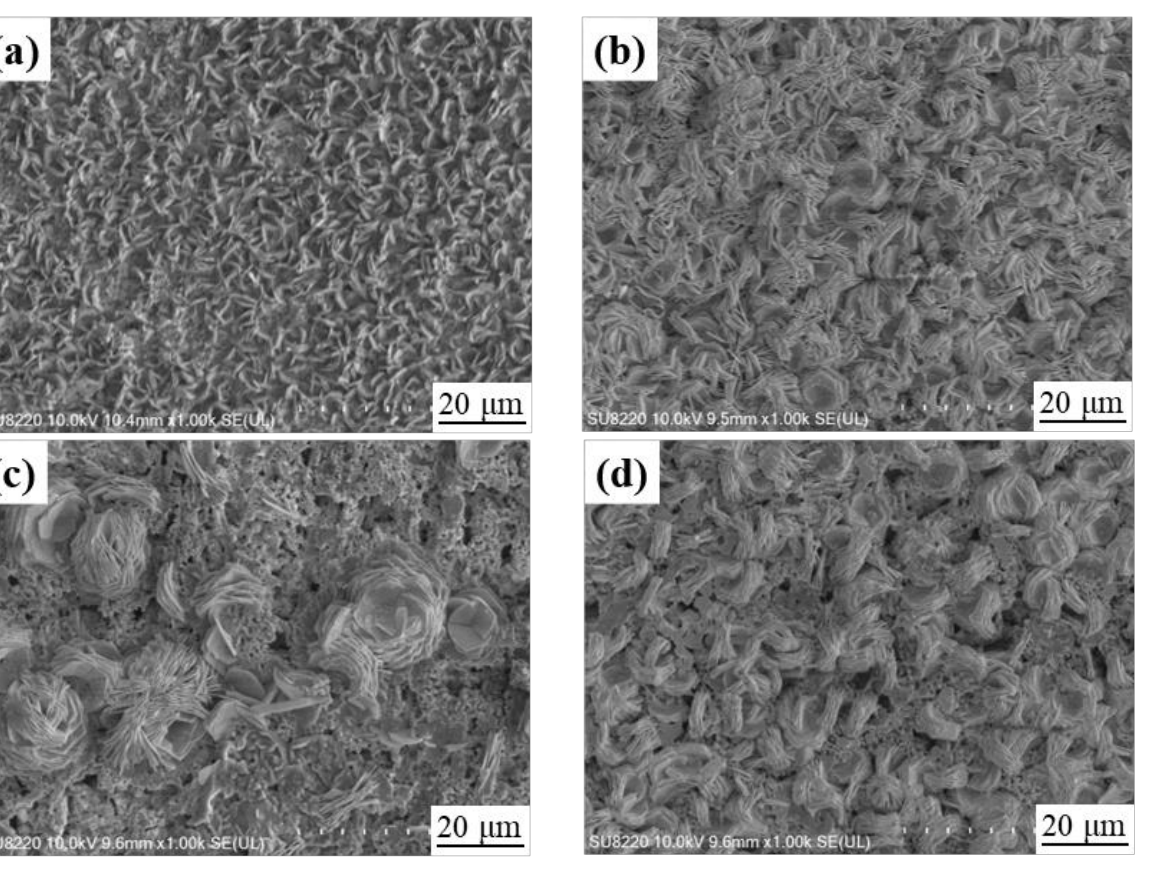
Figure 9. SEM images of corrosion morphology; ( a – f ) the morphologies of MC Sn-20Bi- q GNSs ( q = 0, 0.01, 0.02, 0.04, 0.06, 0.1wt.%); ( g , h ) EDS analysis results of MC Sn-20Bi-0.01GNSs and MC Sn- 20Bi-0.02GNSs corrosion products (red frames).